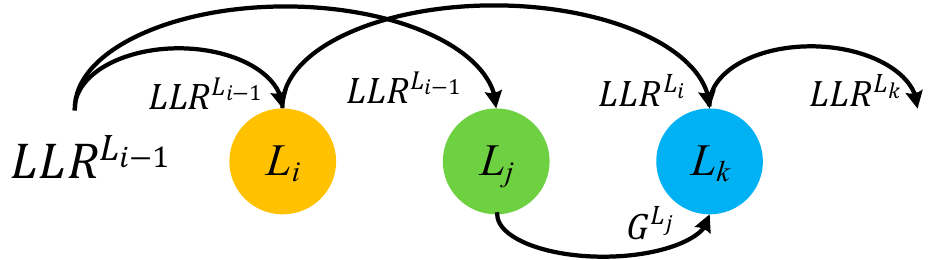
Figure 1. Illustration of the priority-based layered schedule for pipeline conflicts.